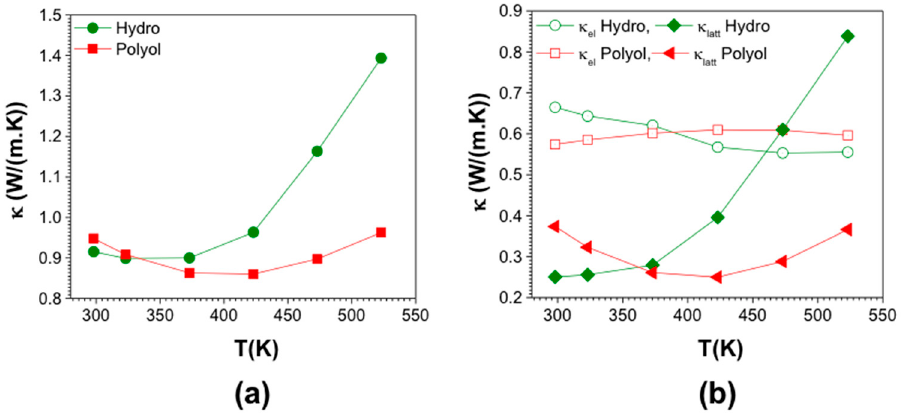
Figure 8. Total thermal conductivity ( a ), along with the electronic and thermal contributions to the thermal conductivity ( b ) for SPS compacted pellets for hydrothermal and polyol synthesized Bi 2 Te 3 . Regardless of the synthetic route, the total thermal conductivity of the materials is lower than that of the current best-known n-type Bi 2 Te 2.925 Se 0.075 ( κ tot = 1.65 W/m · K at 300 K in which the κ lat was 1.27 W/m · K) [16], and are also comparable to those of ball milled and dc hot pressed n-type Bi 2 Te 2.7 Se 0.3 bulk samples ( κ tot = 1.06 W/m · K at 300 K in which κ lat was 0.7 W/m · K) [107]. This strongly suggests that the nanostructure obtained through the developed synthetic routes plays a very significant role in reducing the κ lat through effective phonon scattering.